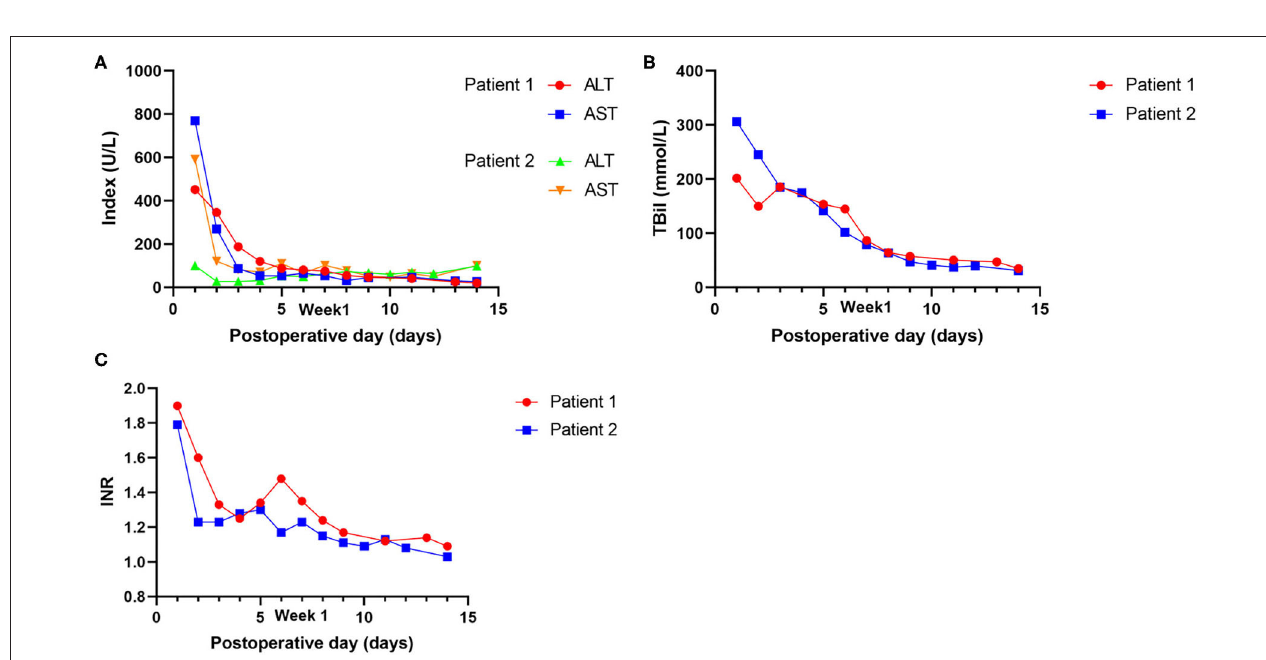
FIGURE 3 | Postoperative outcomes of laboratory tests of the recipients. (A) Changes in transaminases (AST and ALT). (B) Changes in Tbil. (C) Changes in INR.